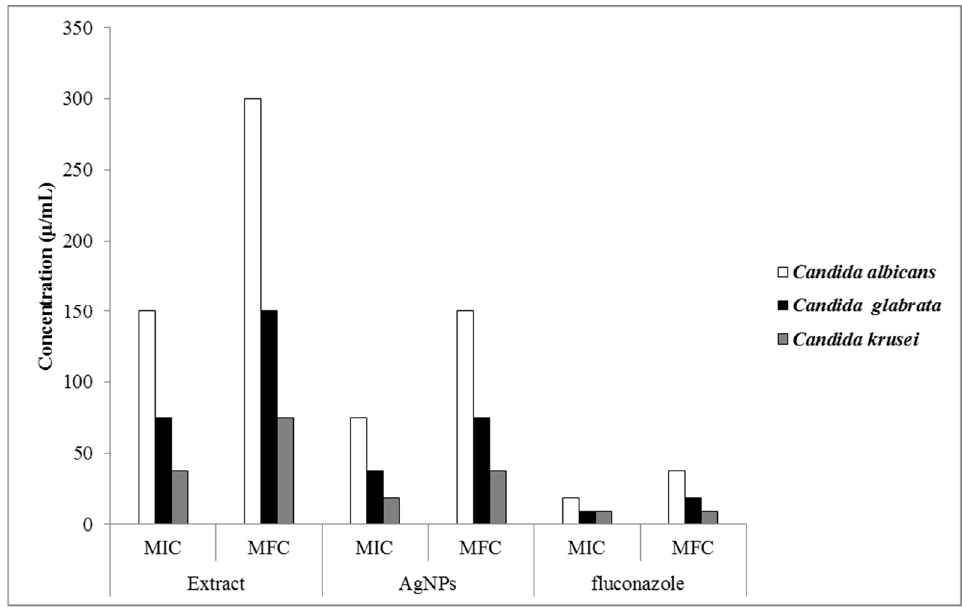
Figure 7. The antifungal activity of the O. persica leaf extract and the phytofabricated AgNPs. Nanomaterials 2021 , 11 , x FOR PEER REVIEW